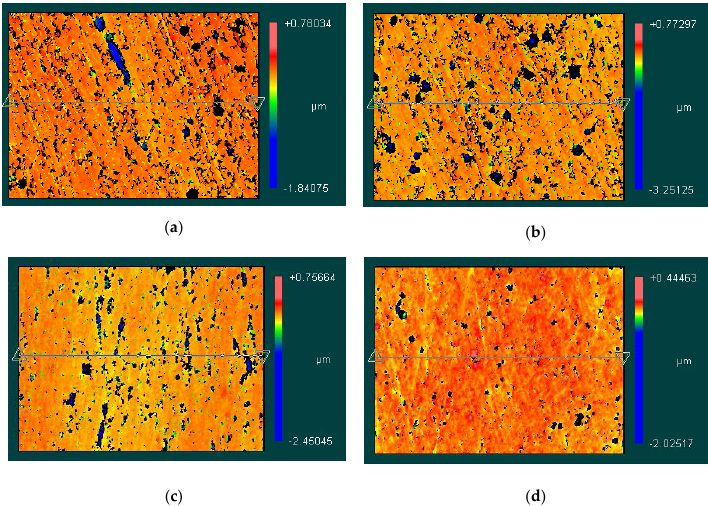
Figure 14. 3D topography of finished surfaces. ( a ) the 3D topography when processing voltage is 4.0 V; ( b ) the 3D topography when processing voltage is 3.8 V; ( c ) the 3D topography when processing voltage is 3.6 V; and ( d ) the 3D topography when processing voltage is 3.4 V.